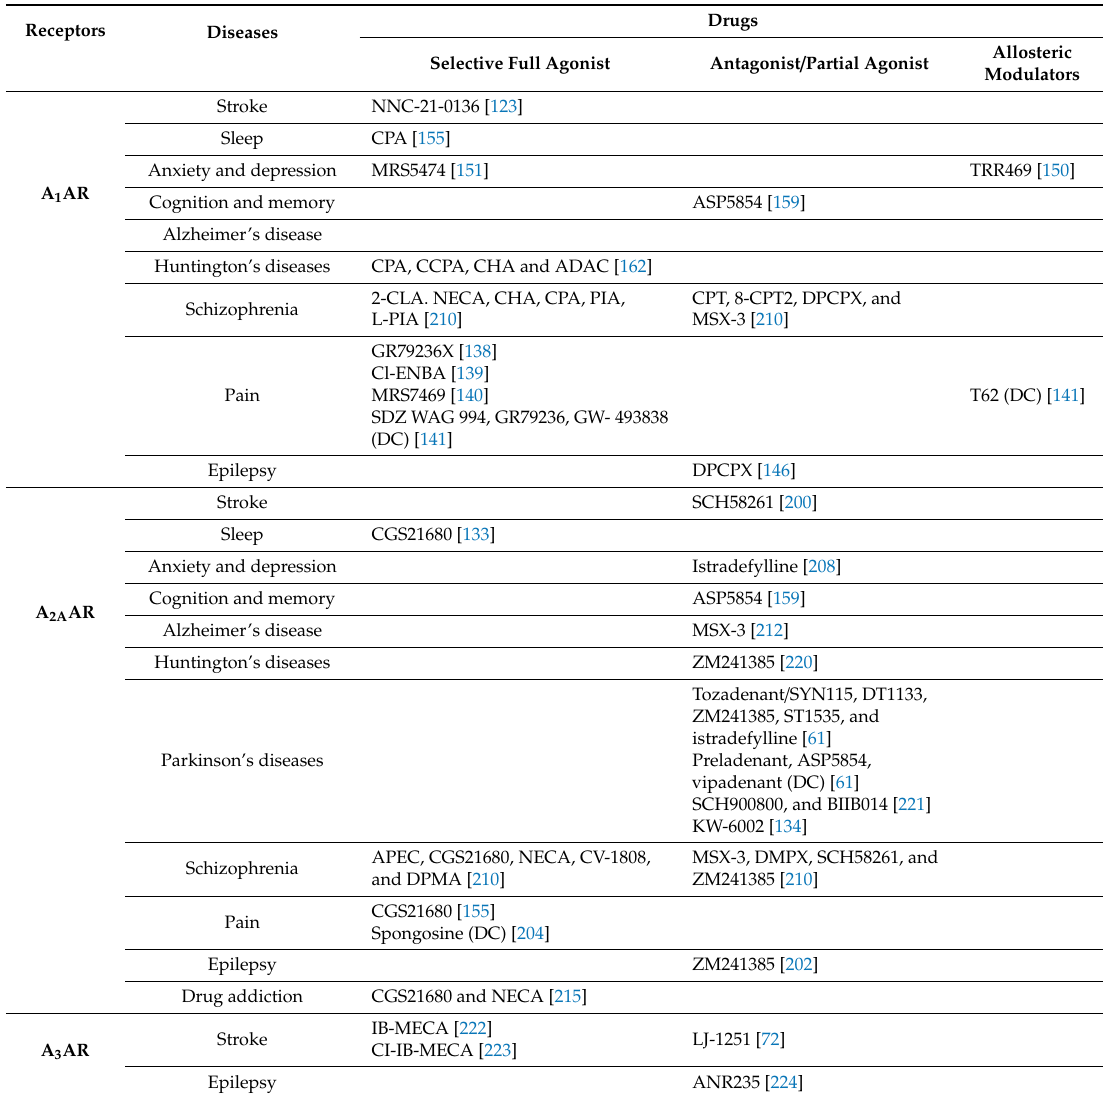
Table 3. Adenosine receptor drugs in CNS